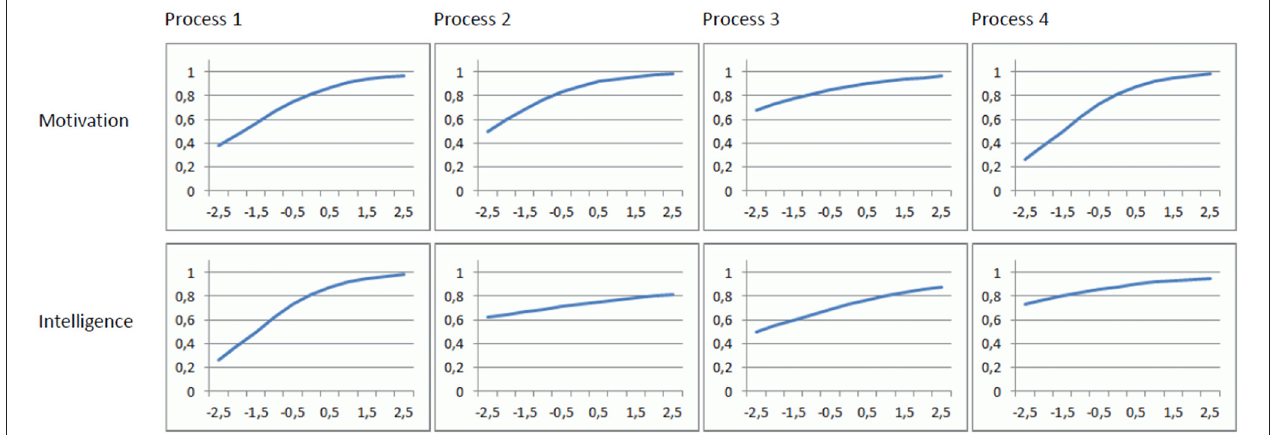
FIGURE 1 | Functional relations between the simulated individual differences variables “Motivation” and “Intelligence” and the probabilities of starting and accomplishing each process. For example, with a motivation of 0.0 (interpreted as a z -value) the probability of starting Process 1 equals